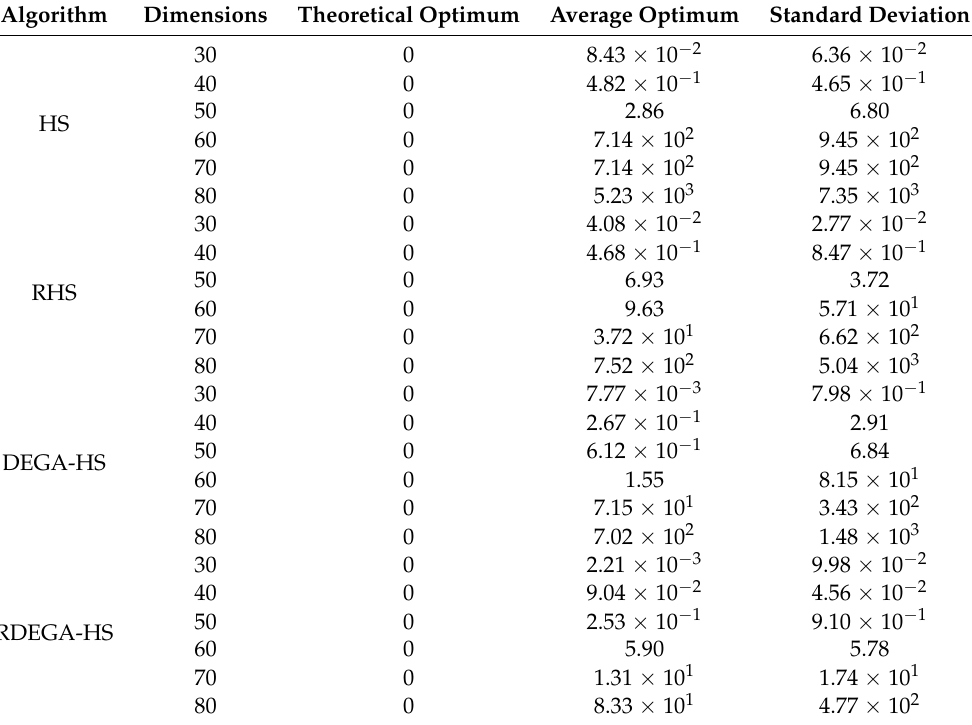
Figure 7. Change in average optimal fitness value of Rosenbrock function with number of iterations. Table 7. Results of the Rosenbrock function under different optimization